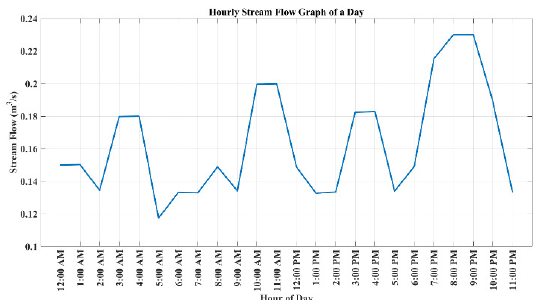
Fig. 10: Stream flow graph for micro-hydro plant